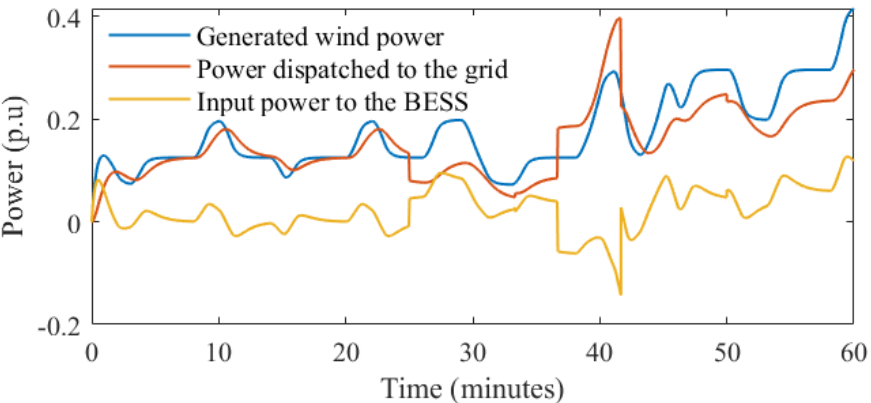
Figure 10. Generated wind power, power dispatched to the grid and BESS input power profiles for a one-hour